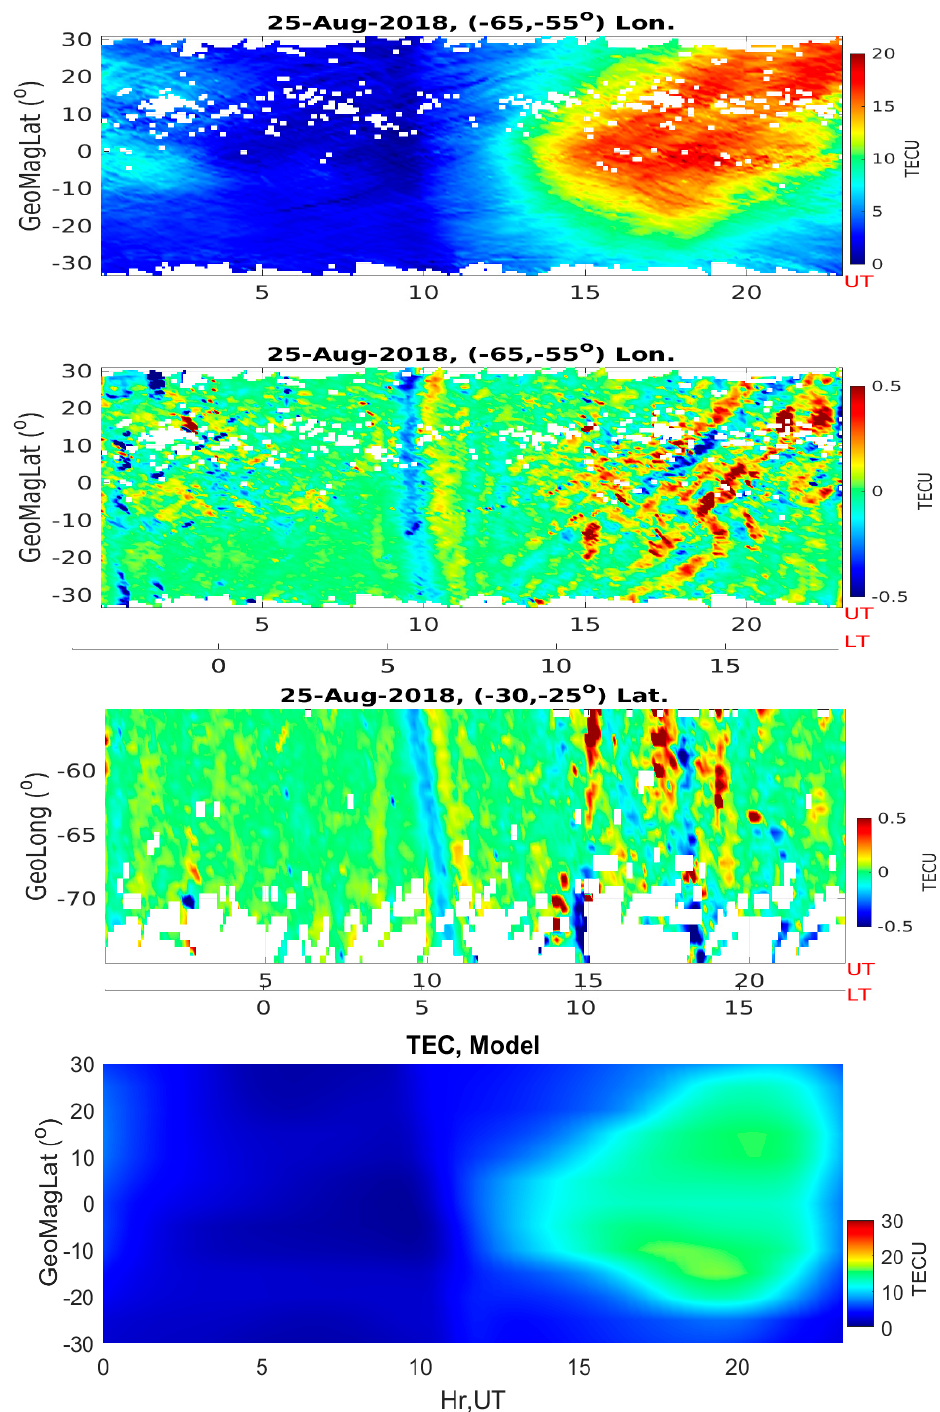
Figure 8. The same plots as Figure 8, but for 25 August 2018.